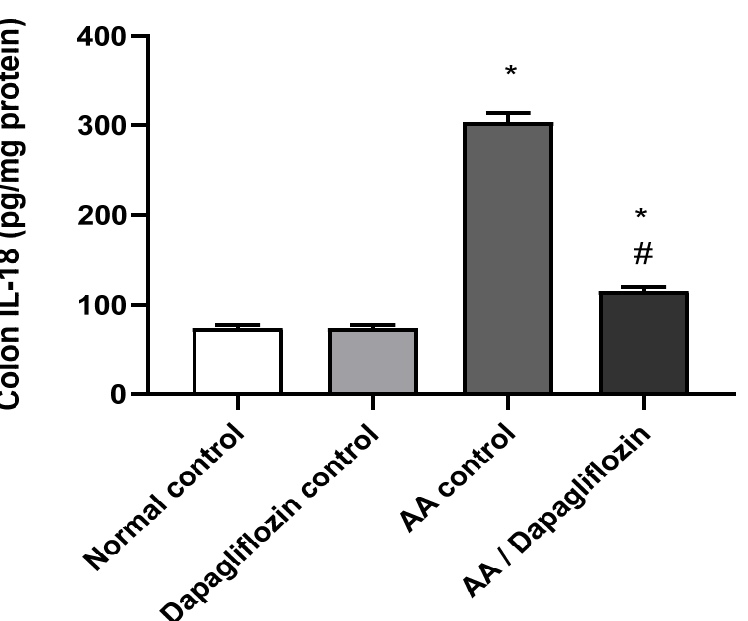
Figure 3. Effect of DAPA on AA-induced change in Interleukin- 18( IL-18) in colon tissue. Data are expressed as mean ± SEM. Superscript letters indicate the level of statistical significance that was performed using one-way ANOVA followed by the Tukey–Kramer multiple comparison test (* p ˂ 0.05, DAPA significantly different from the normal control group, # p ˂ 0.05, DAPA significantly different from the AA control group).